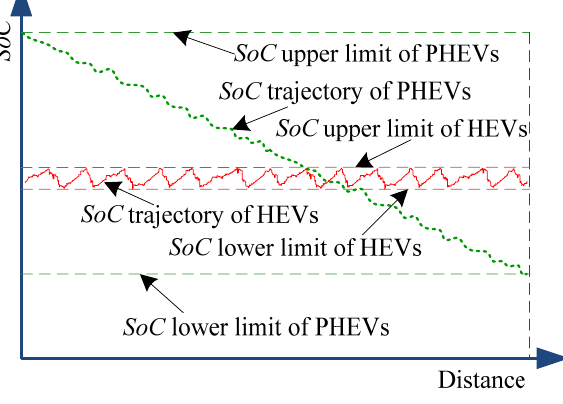
Figure 15. The optimal SoC trajectory of HEVs and